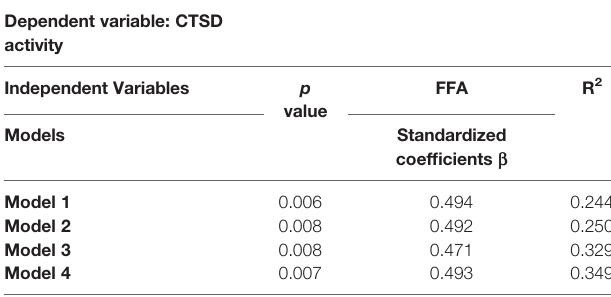
TABLE 2 | Plasma FFA is independently (positively) associated with plasma CTSD activity in male individuals.